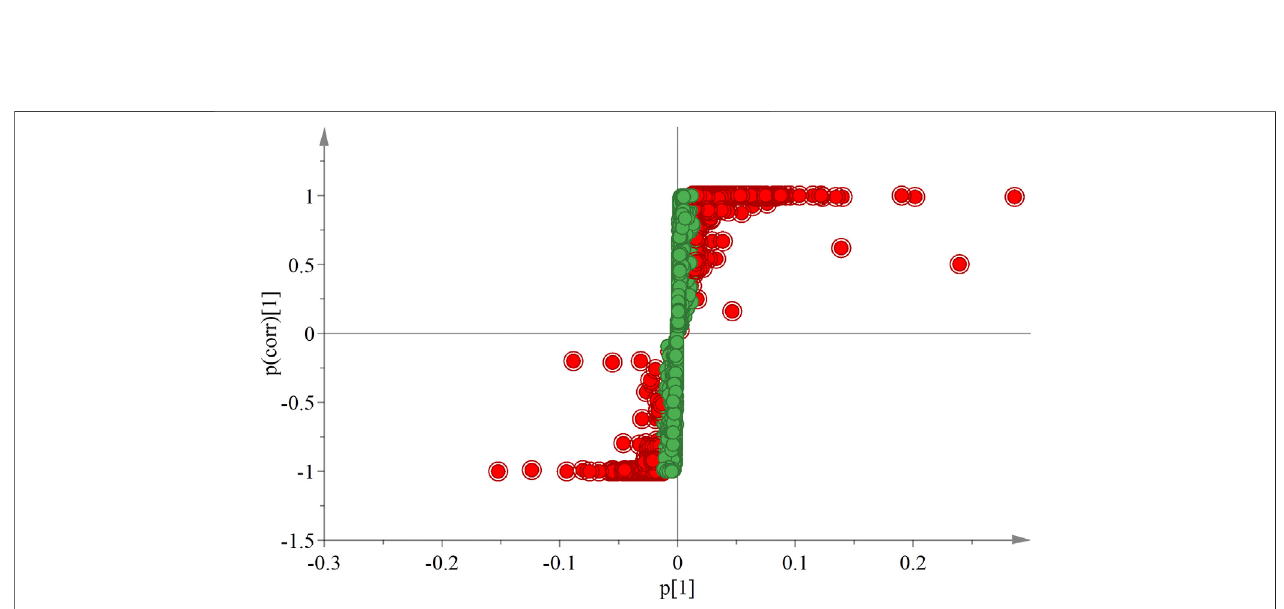
FIGURE 5 | S-plot chart of ULRA and YF groups. The VIP value of red dots is greater than 1. ULRA, unprocessed lateral root of Aconitum carmichaelii ; YF, Yinfupian; VIP, variable important in projection.